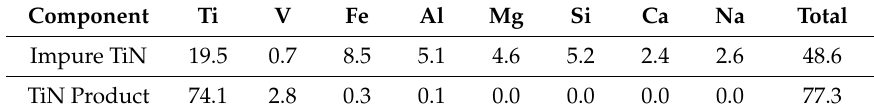
Table 5. Chemical composition of the impure TiN and TiN product (mass %), as determined by XRF analysis.